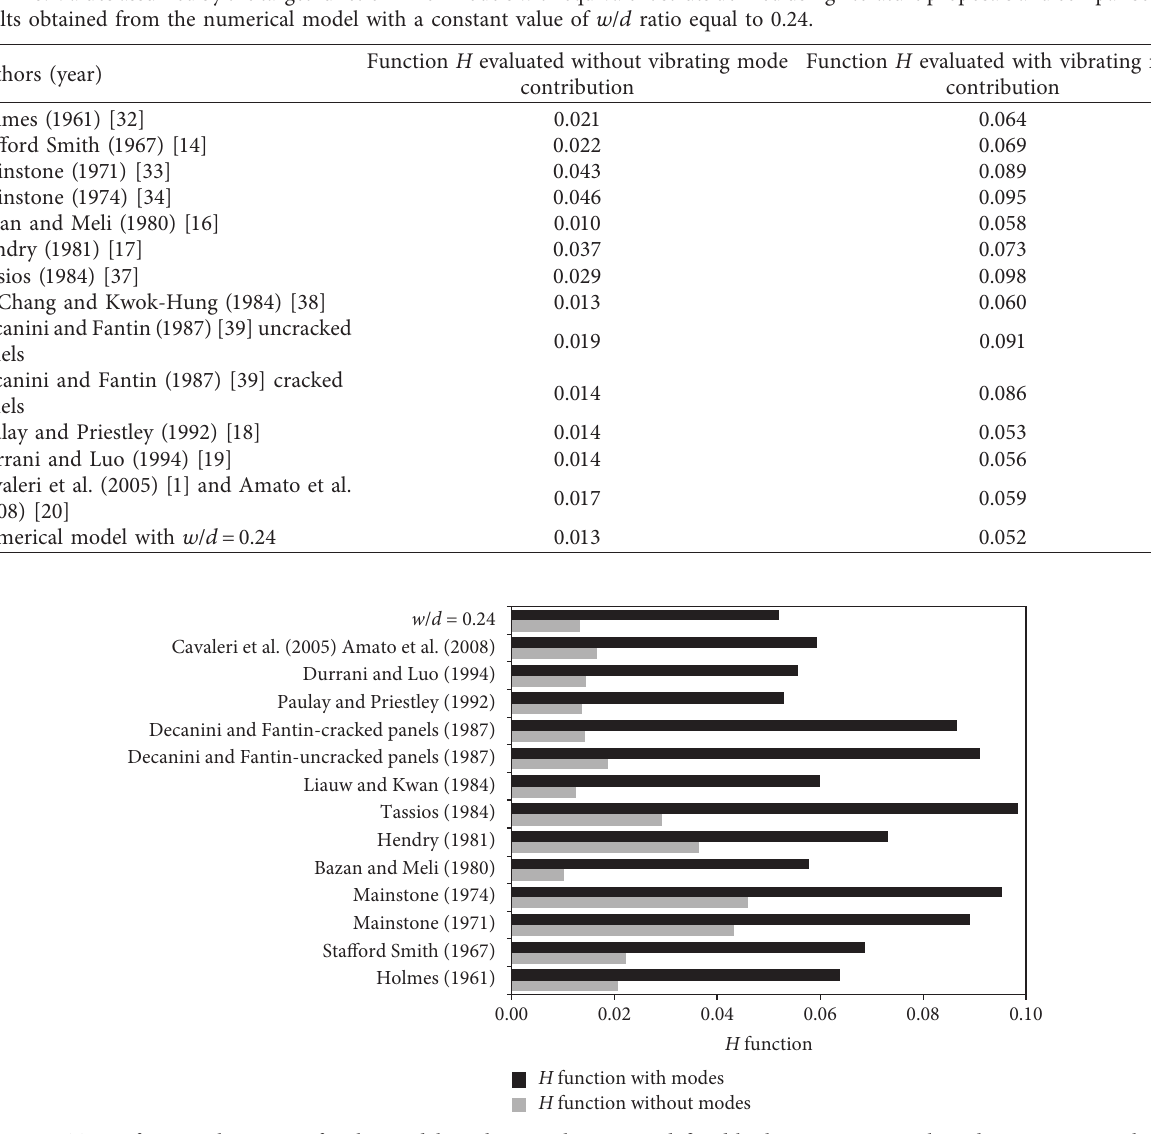
Figure 10: Target function histogram for the models with equivalent struts defined by literature proposals and comparison with model adopting a constant value of w / d �